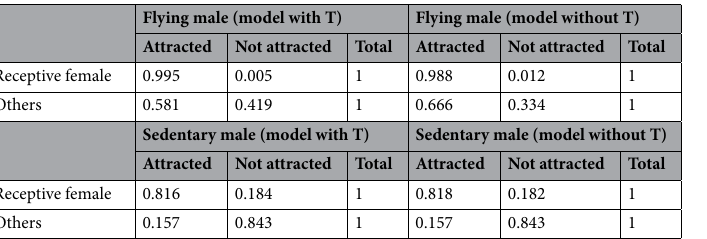
Flying male (model with T) Flying male (model without